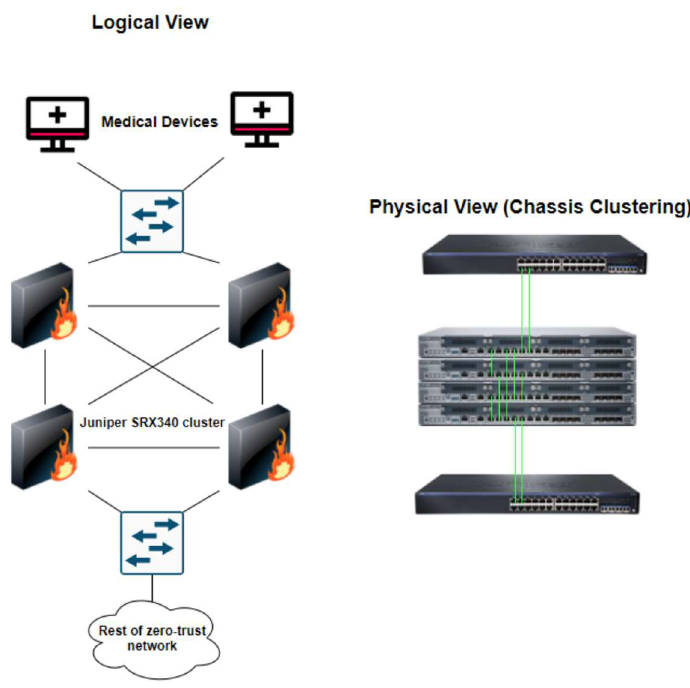
Figure 2. Fault-tolerant firewall clustering to secure medical devices [11].